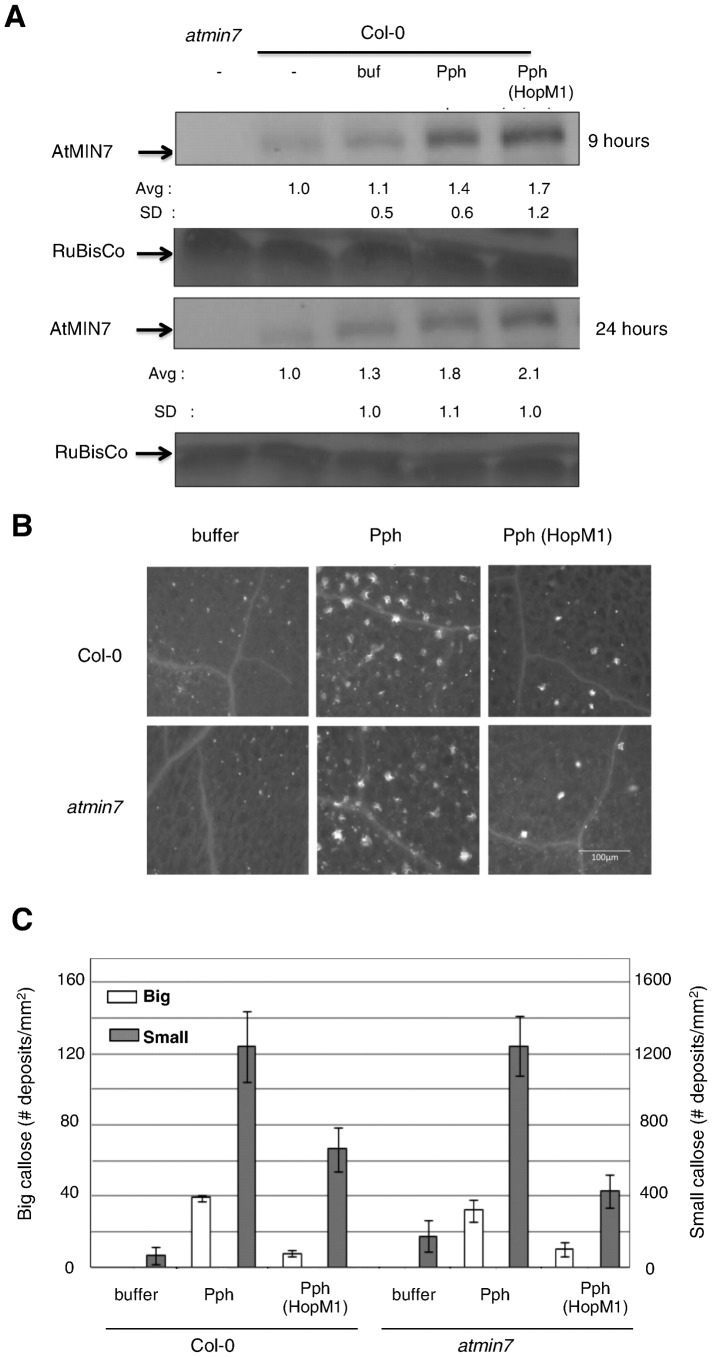
Targets of HopM1 other than AtMIN7 are critical to Pph-induced defense responses.A) Col-0 plants were infiltrated with buffer, Pph, Pph (HopM1) or Col-0 and atmin7 plants were left untreated. AtMIN7 protein levels were measured from samples collected at 9 and 24 hai by immunoblotting. Quantified data were normalized with the amount of AtMIN7 protein present in untreated Col-0 at each time point set to 1.The average and standard deviations from multiple replicates are shown below the blots. Ponceau staining of RuBisCo indicate equal loading. B) Col-0 or atmin7 plants were infiltrated with buffer, Pph, or Pph (HopM1). After 16 hours, leaves were cleared and stained with aniline blue and visualized by fluorescent microscopy. Representative pictures are shown. The scale bar in the bottom right picture is 100 microns. C) Image J was used to count small and big callose deposits. Shown are the average and standard deviations from three independent biological replicates. Paired two-tailed t-tests indicate that the callose deposits induced in Col-0 versus atmin7 did not differ for Pph or Pph (HopM1) (P>0.6).